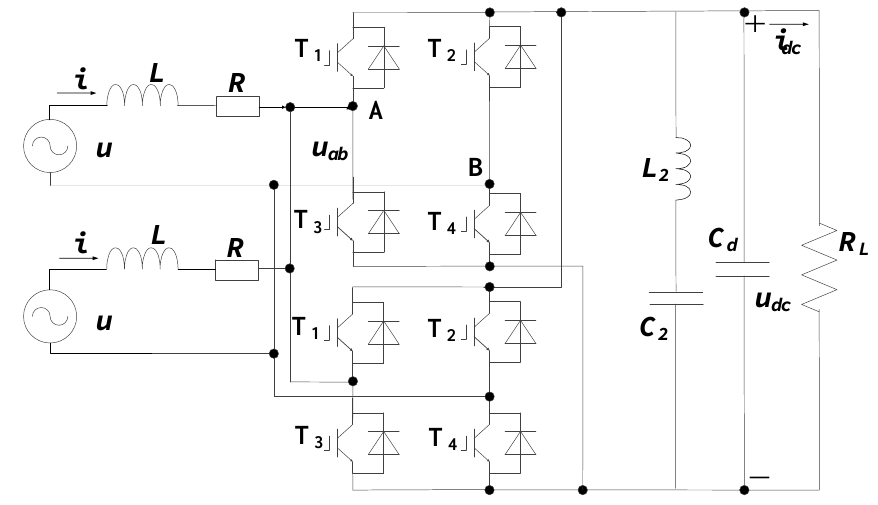
Figure 3. Equivalent circuit of a twofold four-quadrant pulse converter.